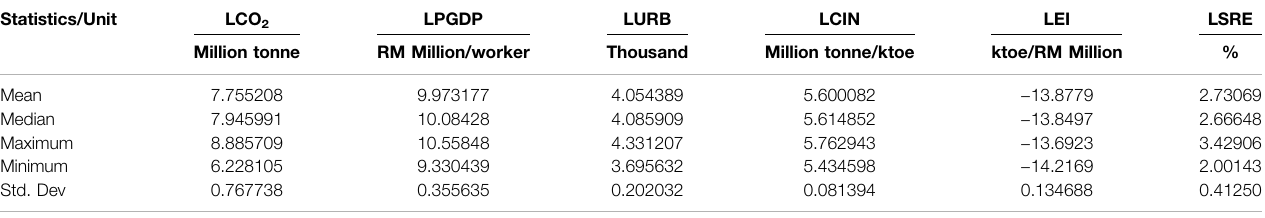
TABLE 1 | Descriptive statistics of variables.